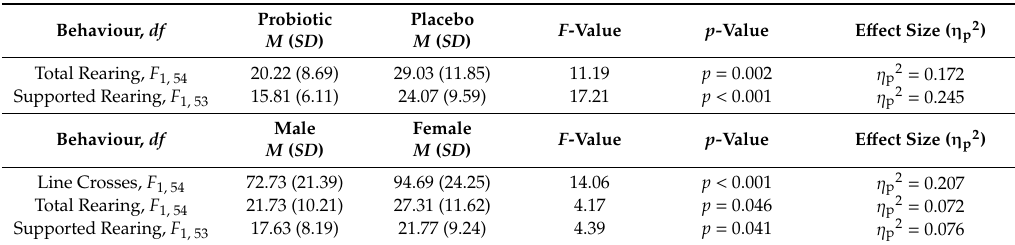
Table 2. Overview of treatment and sex main e ff ects in the open field test from factorial ANOVA analyses for line crosses, total rearing, and supported rearing, including means ( M ) and standard deviations ( SD